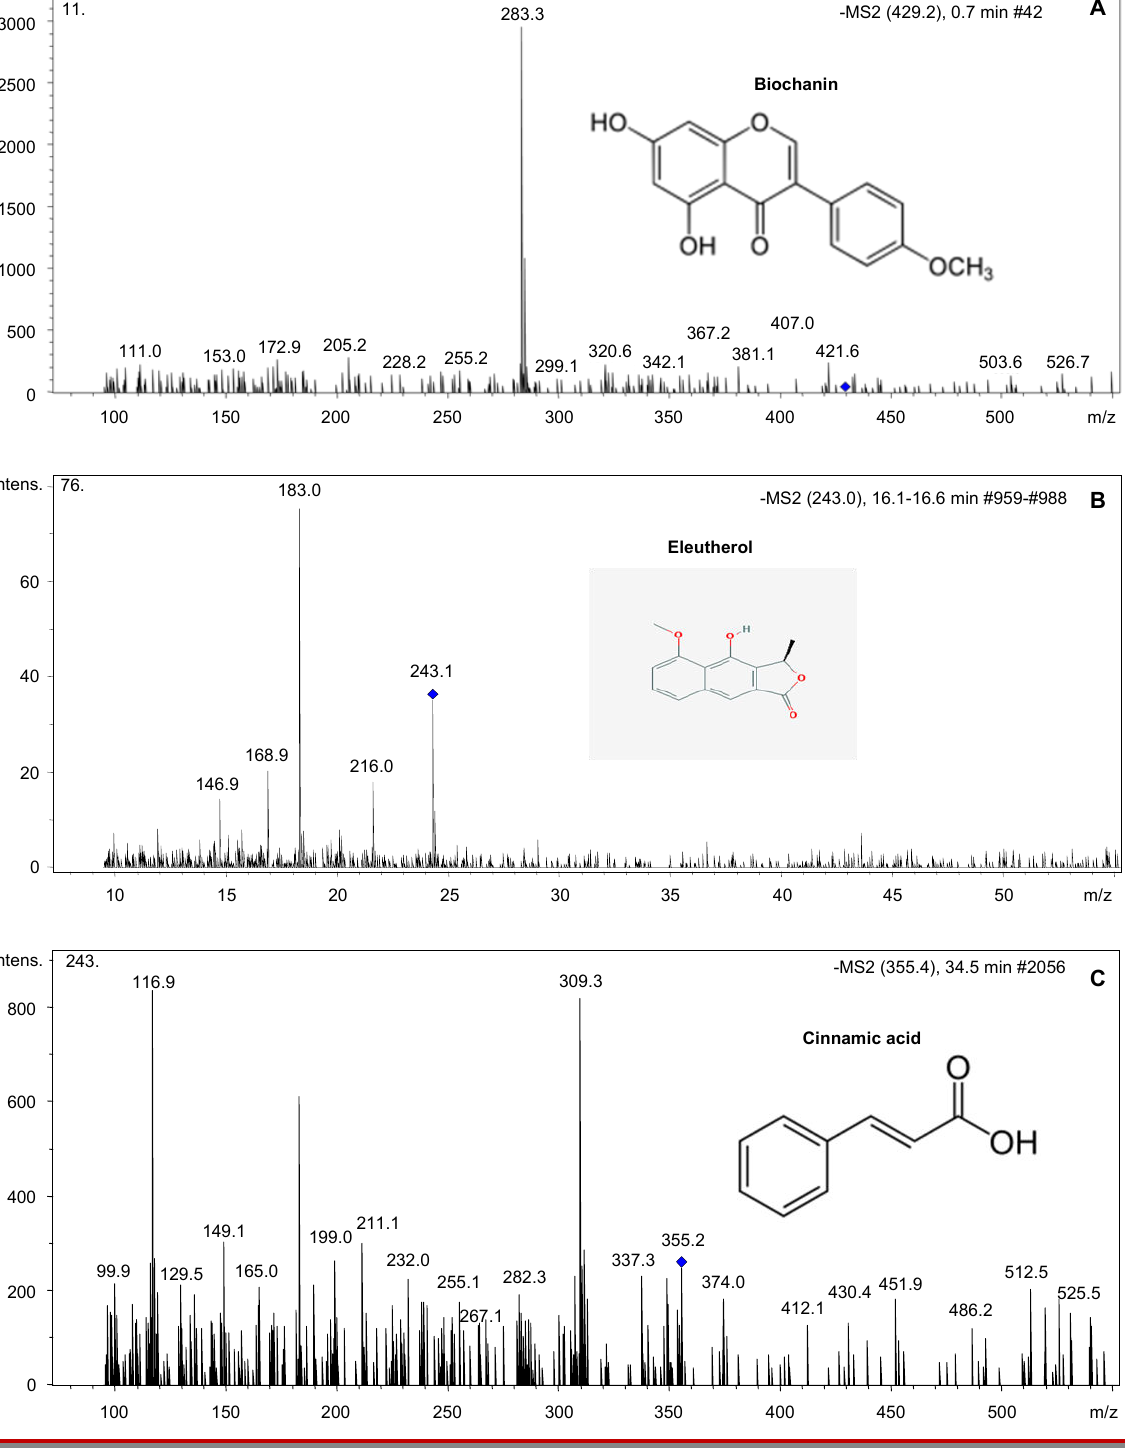
Figure 2 : LC-MS/MS spectrum of ethyl acetate fractions of O. stamineus leaves. A) Biochanin, B) Elutherol and C) Cinnamic acid